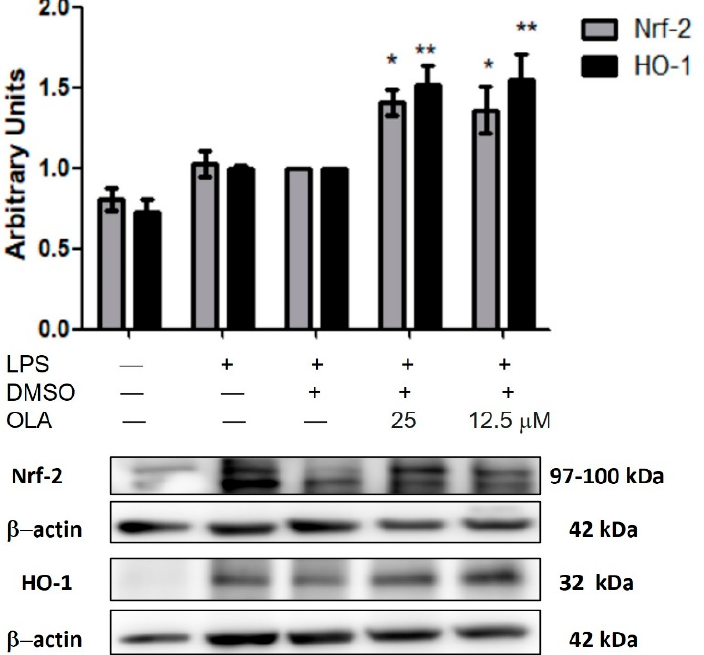
Figure 5. OLA upregulated Nrf-2/HO-1 signaling pathway in LPS-activated peritoneal macrophages. Murine cells were pretreated with OLA for 30 min, followed by LPS stimulation for 18 h. Nrf-2 and HO-1 protein levels were detected by Western blot. Densitometry was performed following normalization to the control ( β -actin housekeeping gene). Data are represented as the means ± SEM ( n = 6). * p < 0.05, ** p < 0.01 vs. LPS − DMSO-treated cells.